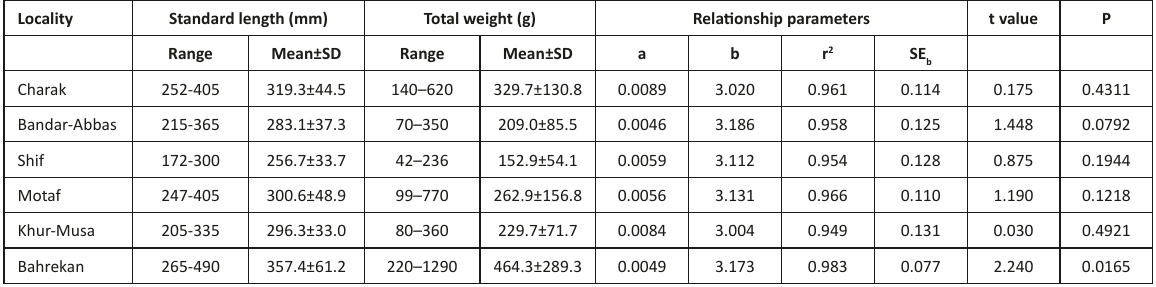
a - intercept; b - slope; r 2